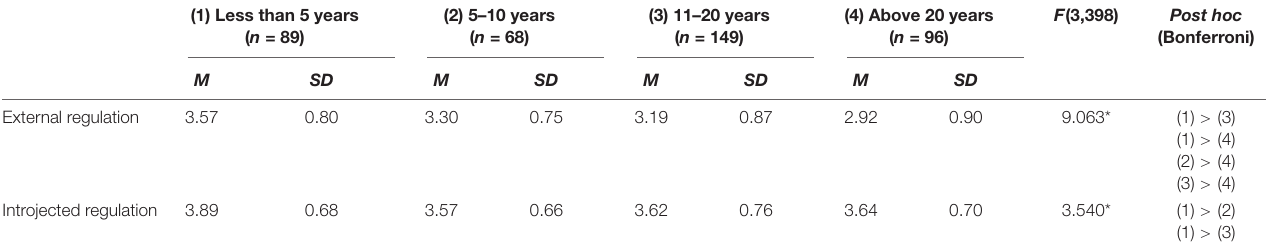
TABLE 5 | Comparison of years in teaching on CPD